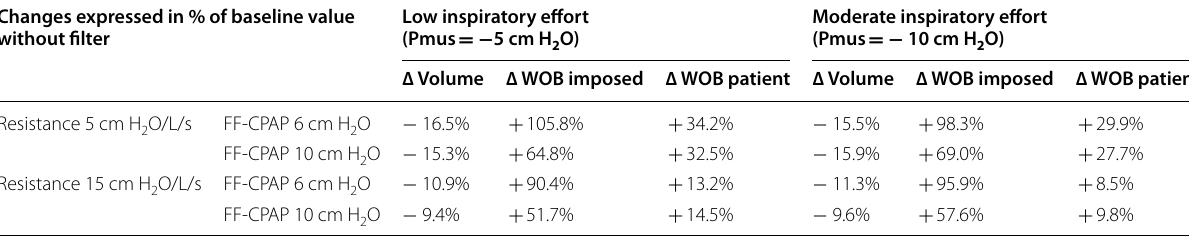
Influence of the filter on tidal volume and work of breathing during low and moderate simulated inspiratory efforts Pmus simulated muscle pressure, ∆ Volume tidal volume variation induced by the filter as compared to baseline (without filter), ∆ WOBimposed variation of work of breathing imposed by the CPAP induced by the filter as compared to baseline (without filter). WOBimposed was calculated from the airway pressure–volume loop. ∆ WOBpatient variation of simulated patient’s work of breathing needed to maintain the tidal volume constant after having added the filter. WOBpatient was calculated from the muscle pressure–volume loop, PEEP positive end-expiratory pressure, FF-CPAP filter frugal continuous positive airway pressure (see text for definition)